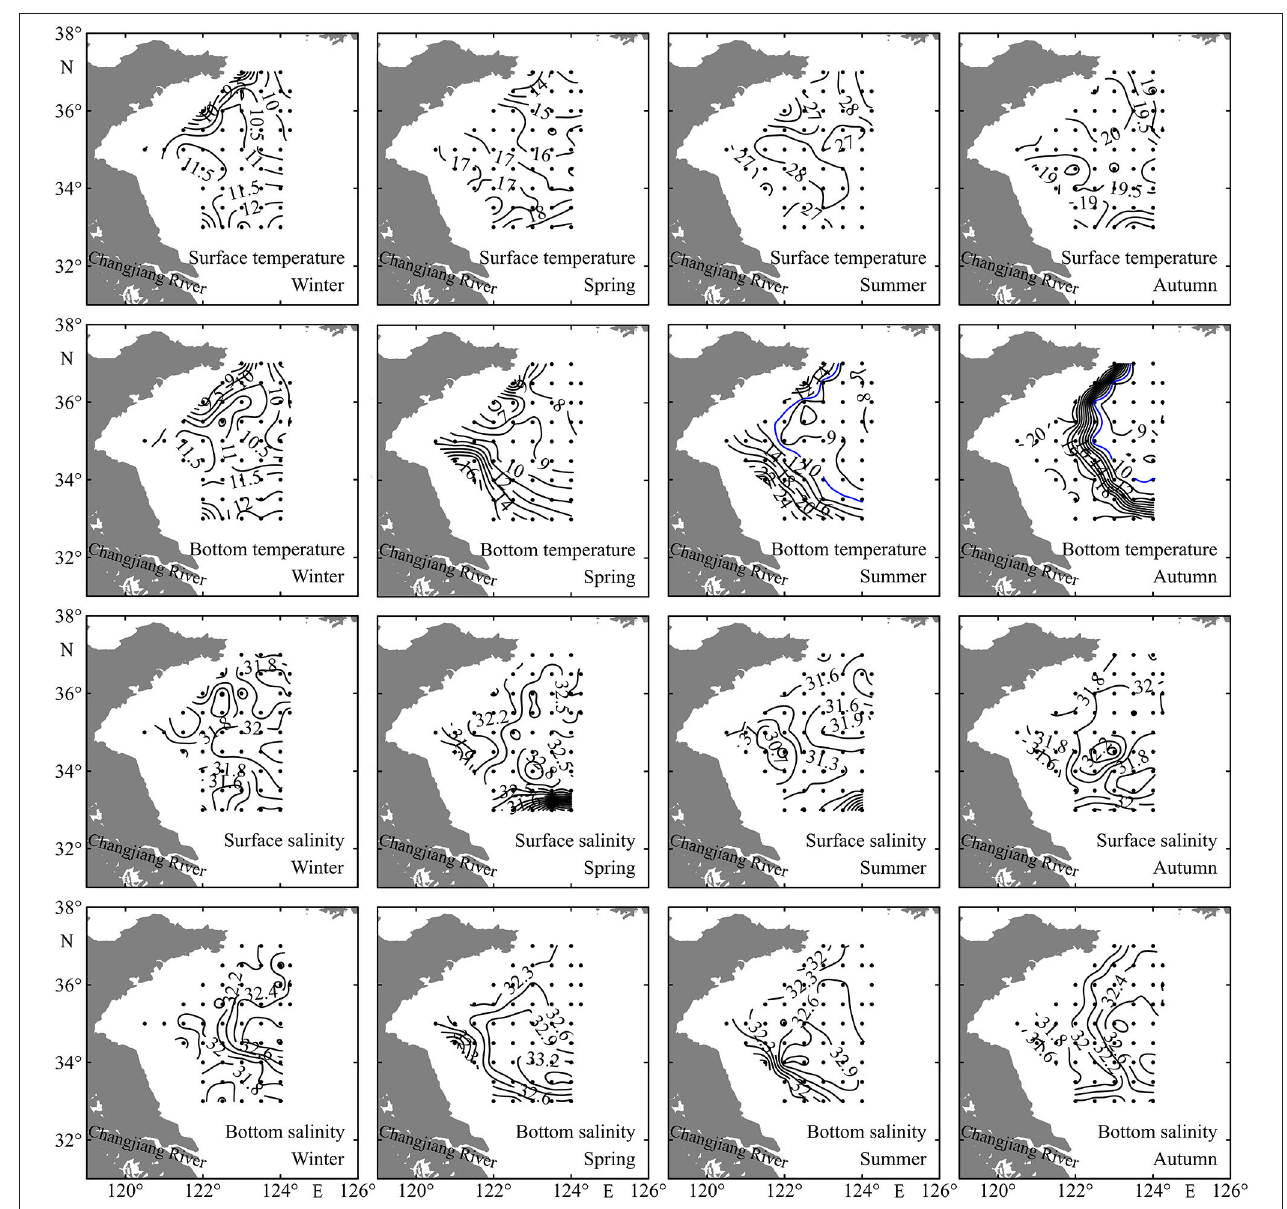
FIGURE 2 | Spatial distributions of sea surface temperature ( ◦ C), bottom temperature ( ◦ C), surface salinity, and bottom salinity in the Yellow Sea during four seasons.